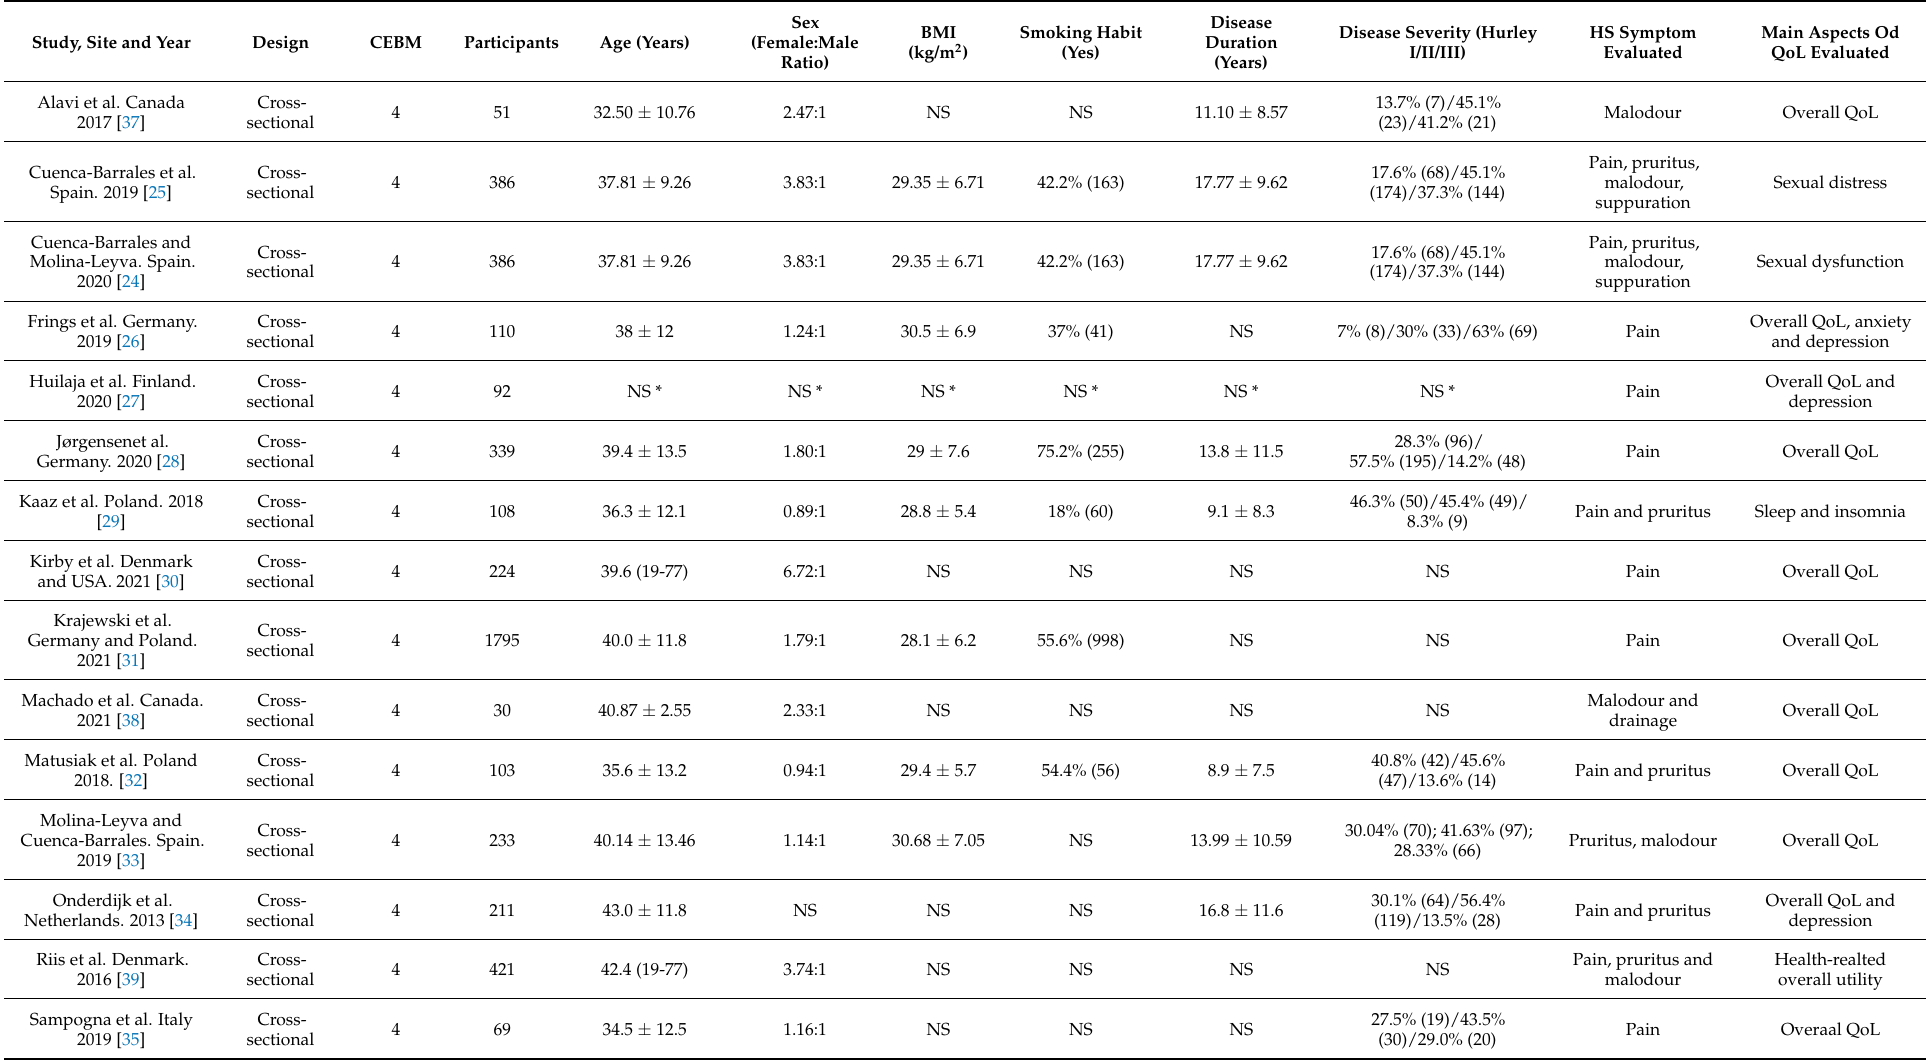
Table 1. Main characteristics of the studies regarding HS symptoms impact on